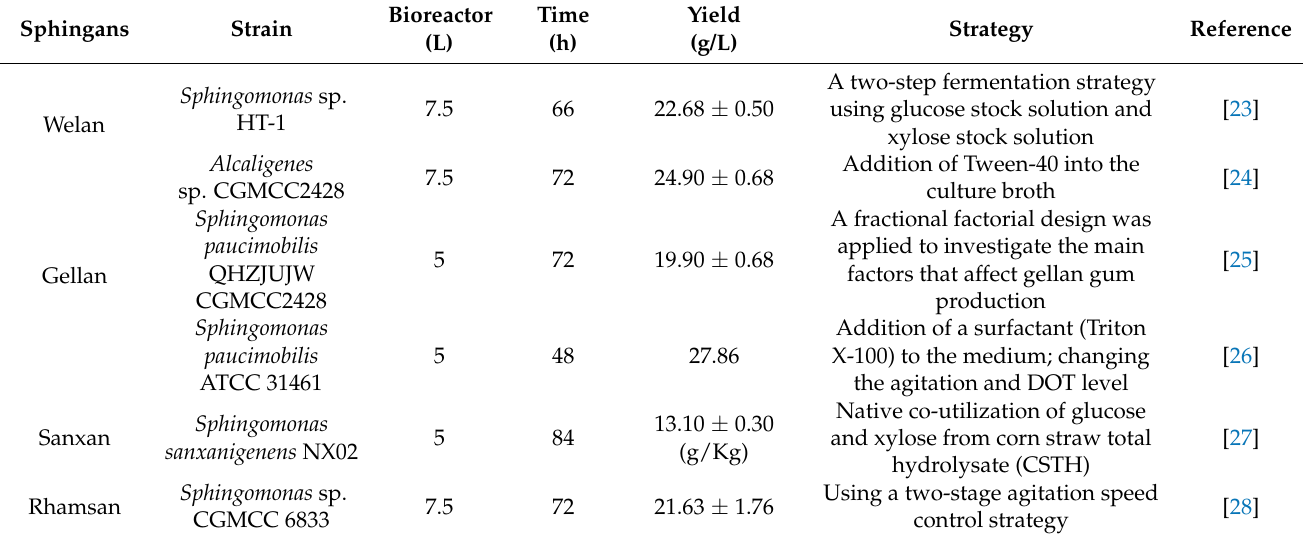
Table 1. Sphingomonas strains and corresponding